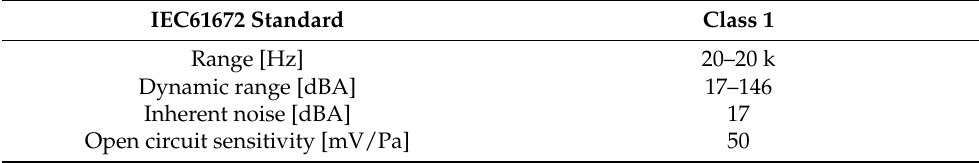
Table 1. Characteristics of the BSWA MPA-201 microphone.